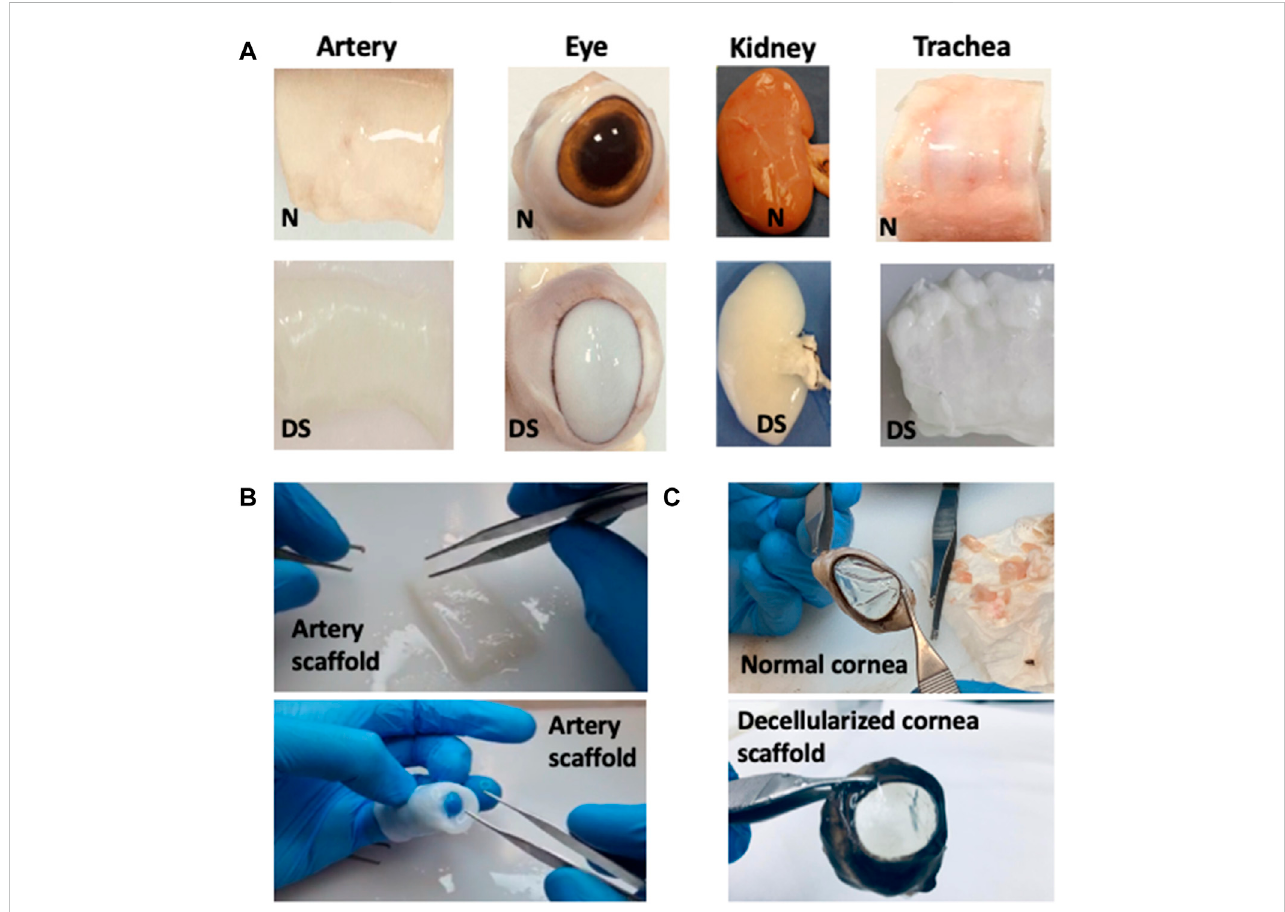
FIGURE 3 The formation ofvarioustissue and organ scaffolds. These images illustrate the conversion ofnative tissues/organsinto the decellularized (A) artery, eye (initially with substantially reduced optical transparency), kidney, and trachea scaffolds, where N = native scaffold and DS = decellularized scaffold, (B) a decellularizedarterialscaffoldillustratingsignsofretained fl exibilityandstructuralintegrity,and (C) decellularizedcornealscaffoldopacityreversedtoprovide a degree of transparency comparable to the native (normal) extracted